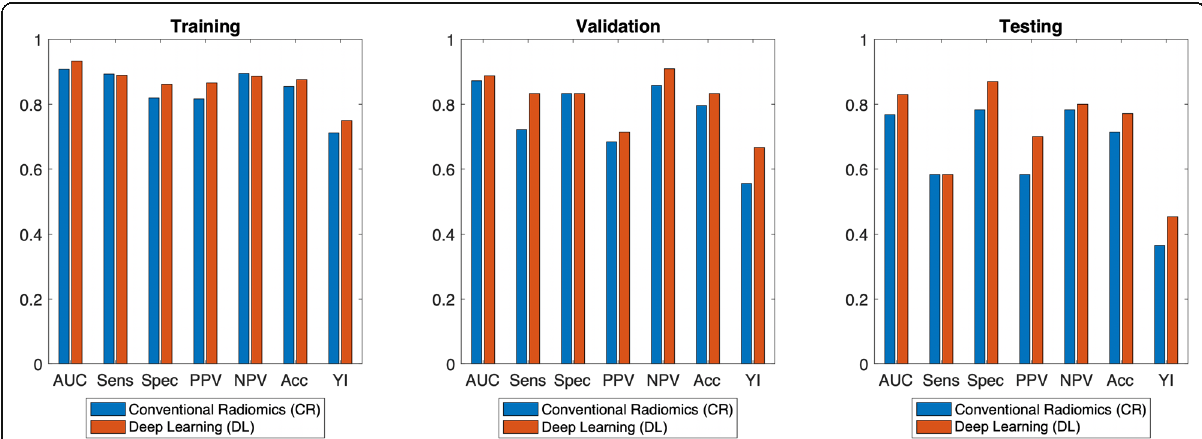
Fig. 5 Predictive performance of feature models including intratumoral and 4 mm peritumoral region with CR and DLB pipeline. The DLB pipeline slightly outperformed CR in the validation set. A larger improvement is seen in the testing set of dissimilar resolution. This indicates the DLB pipeline might be more generalizable and insensitive to pixel size differences. Note that the performance of the training set is not used for comparison due to overfitting concerns. AUC: area under the curve; Sens: sensitivity; Spec: specificity; PPV: positive predictive value; NPV: